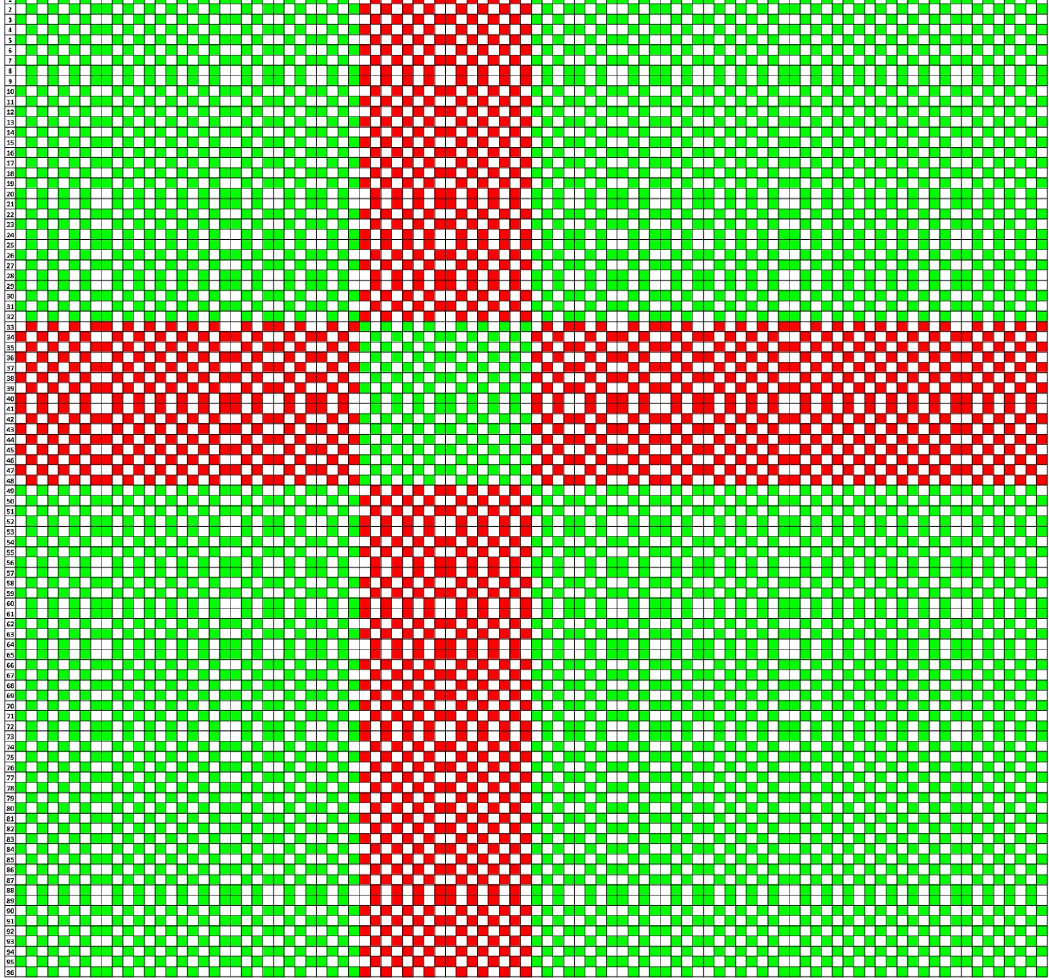
Figure 3 . Graphical representation of the values in the adinkra Gadget representation